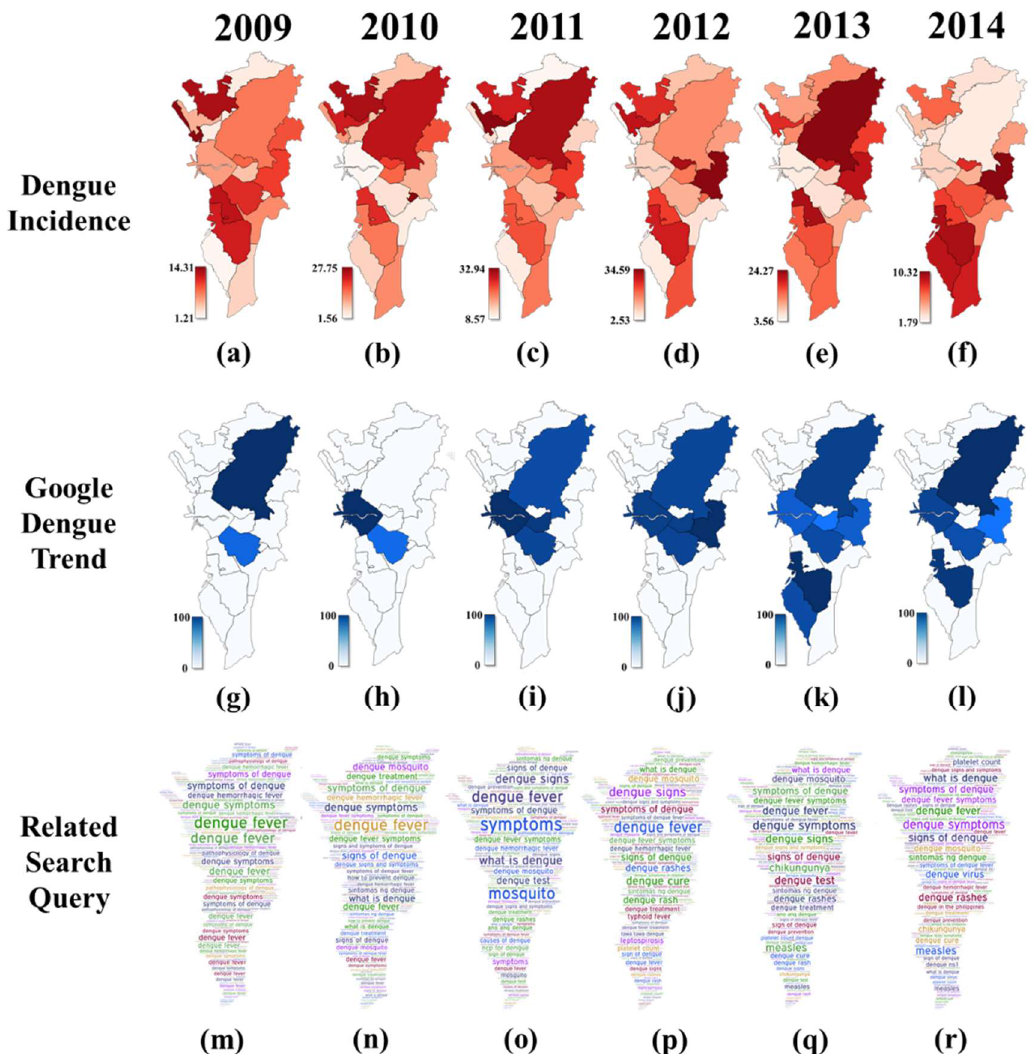
Figure 3. City level spatio-temporal pattern of dengue incidence ( a – f ) and Google Dengue Trends ( g – l ). Temporal word clouds maps of dengue-related search query in Metropolitan Manila ( m – r ).